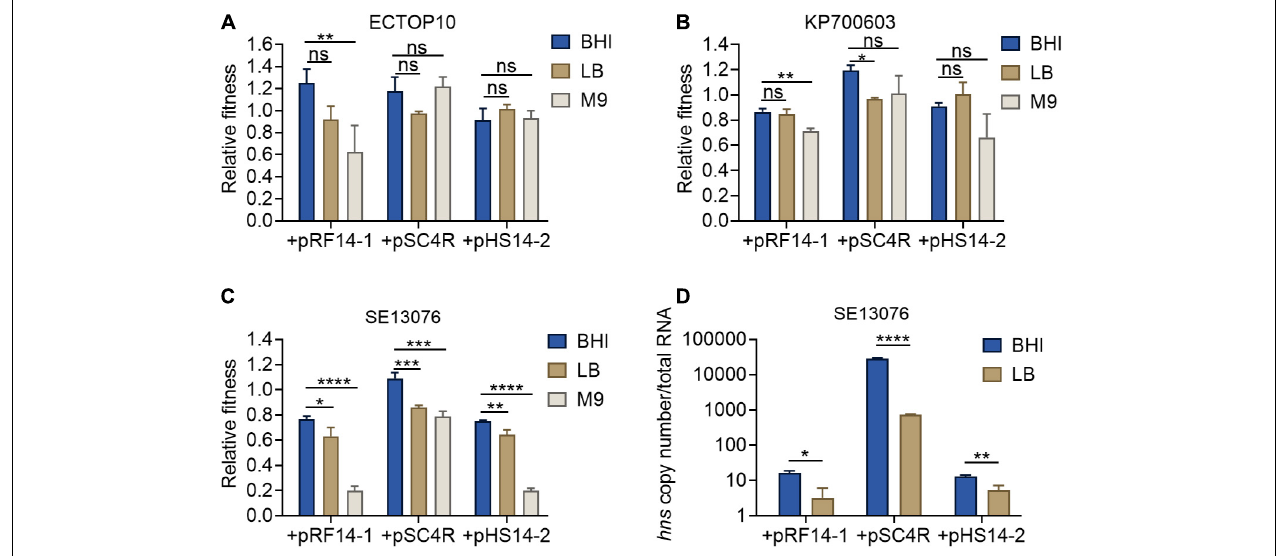
FIGURE 5 | Fitness and hns expression of host bacteria under different nutritional conditions. (A–C) Relative fitness of transformants of E. coli TOP10 (A) , K. pneumoniae ATCC700603 (B) , or S. Enteritidis ATCC 13076 (C) carrying three tet (X4)-bearing IncX1 plasmids in high nutritional BHI culture, medium nutrition LB broth, and low nutrition M9 culture. p -values were determined using a non-parametric one-way ANOVA (* p < 0.05, ** p < 0.01; ns, not significant). (D) Absolute expression of hns gene in transformants of S. Enteritidis ATCC13076 as recipient. Data are representative of three biological replicates and shown as mean ± SD.